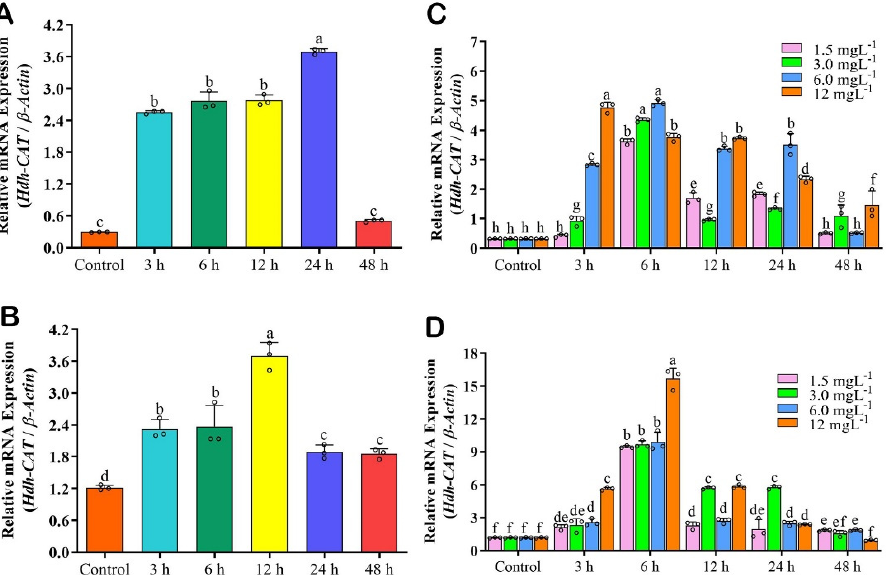
Figure 4. Hdh-CAT mRNA expression levels in H 2 O 2 induced and cadmium (Cd) exposed (1.5 mgL − 1 , 3.0 mgL − 1 , 6.0 mgL − 1 , and 12.0 mgL − 1 ) Pacific abalone at different time points. ( A ) Hdh-CAT mRNA expression level in gill of H 2 O 2 induced Pacific abalone. ( B ) Hdh-CAT mRNA expression level in digestive gland (DG) of H 2 O 2 -induced Pacific abalone. ( C ) Hdh-CAT mRNA expression level in gill of Cd-exposed Pacific abalone. ( D ) Hdh-CAT mRNA expression level in DG of Cd-exposed Pacific abalone. Different letters above the bars indicate significant differences ( p < 0.05).